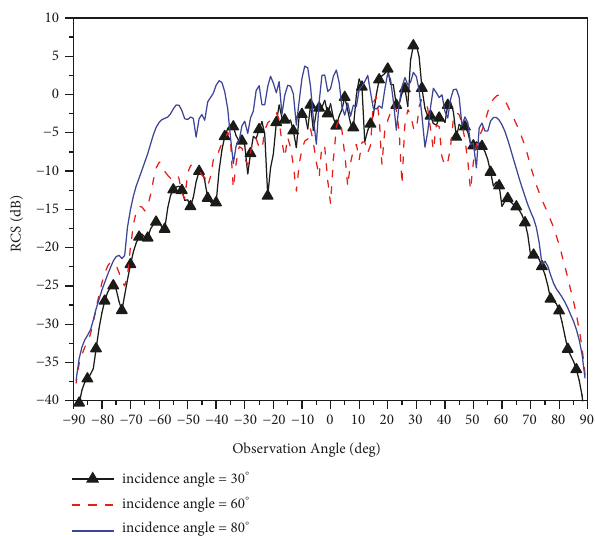
Figure 13: Simulations of the angular variation of RCS for different incidence